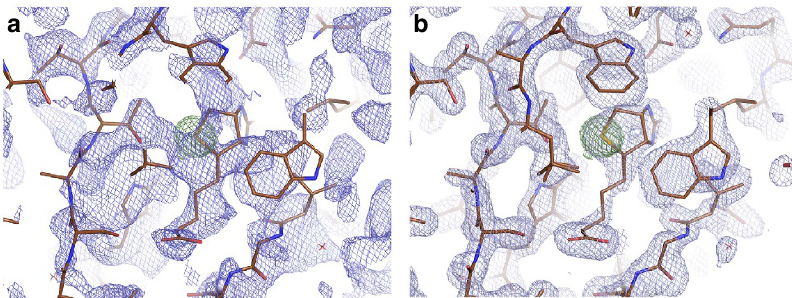
Figure 1 | Electron density at selenobiotin site. ( a ) Electron density of the selenobiotin site before solvent flattening and ( b ) Electron density of the final, refined structure. Model from known structure is shown in both frames and green electron density indicates the location of the Se